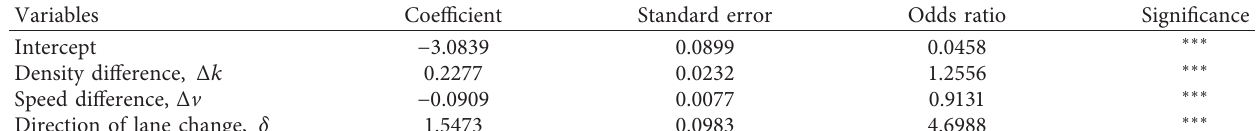
Figure 10: (a) Layout of I80 Highway; (b) cell arrangement and position of I80-Highway in CTM. Table 2: Parameters for the variables considered in the binary logistic lane change model.